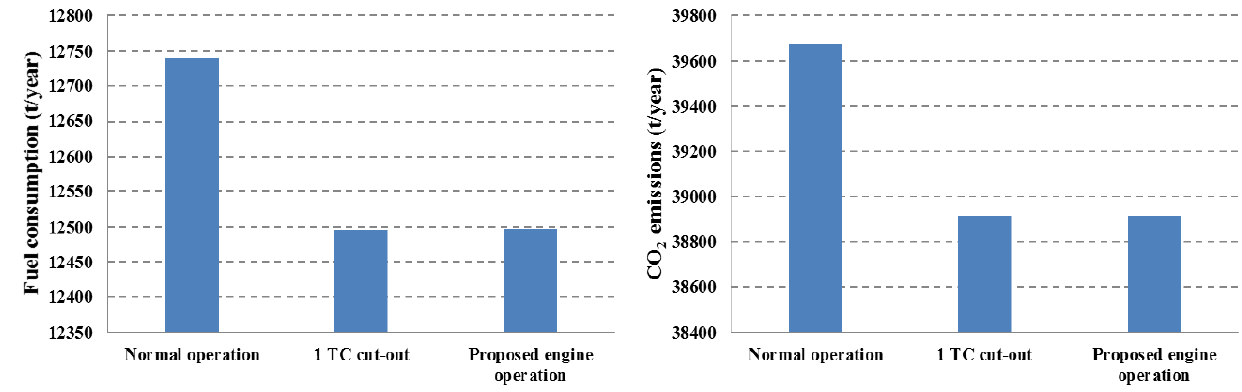
Figure 10. Calculated annual fuel consumption ( left ) and CO 2 emissions ( right